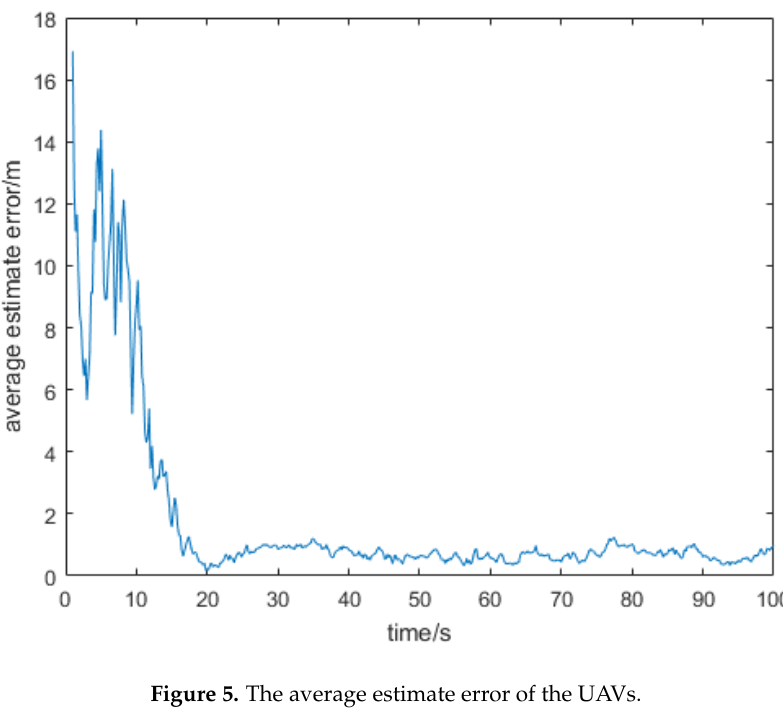
Figure 5. The average estimate error of the UAVs.